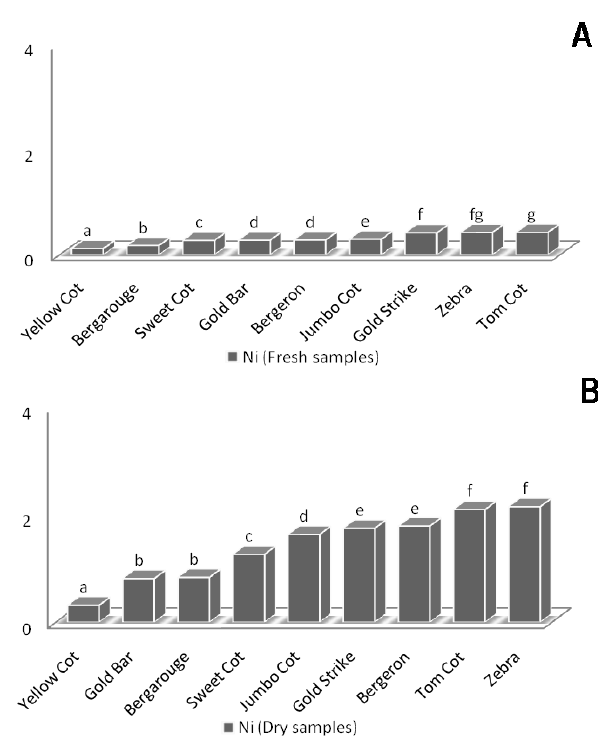
Fig. 2. Concentration of Nickel in apricot cultivars. A: Fresh and B: Dry samples. Columns with different caption have a signifi- cant difference ( p≤